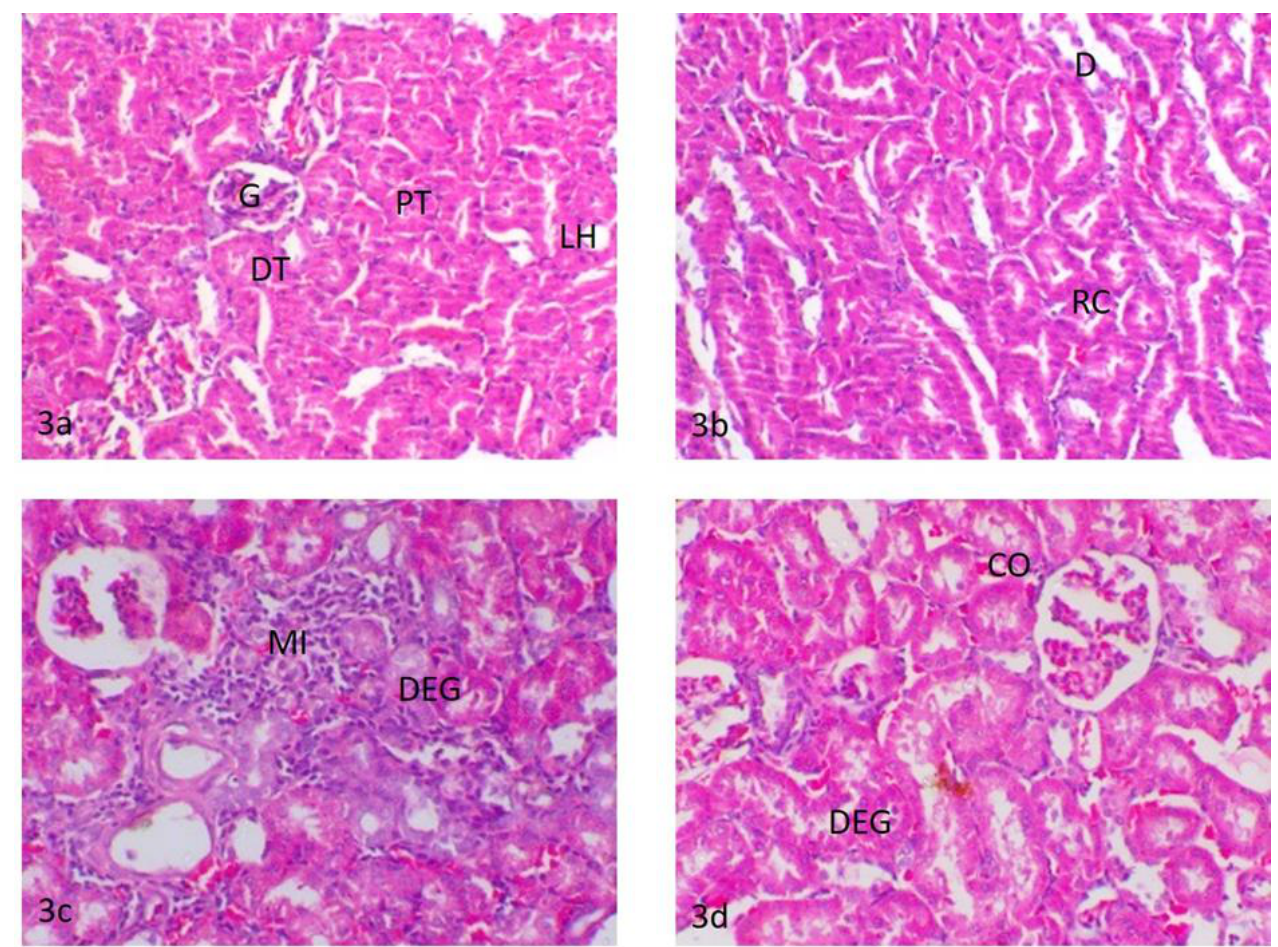
Figure 3. ( 3a ) Kidneys of control rats, glomerulus (G), proximal convoluted tubules (PT), distal convoluted tubules (DT) and loop oh henle (LH); ( 3b ) kidneys of rats treated with water contaminated with dimethoate after remediation with TiO 2 (s)/H 2 O 2 /UV , renal casts (RC) and tubular dilatation (D); ( 3c ) kidneys of rats treated with water contaminated with methomyl after remediation with TiO 2 (s)/H 2 O 2 /UV, periglomerular and intertubular mononuclear cell infiltration (MI) and degeneration of the renal tubules (DEG); ( 3d ) kidneys of rats treated with water containing TiO 2 (s)/H 2 O 2 without any insecticides, degeneration of the renal tubules (DEG) and intertubular blood vessel congestion (CO).